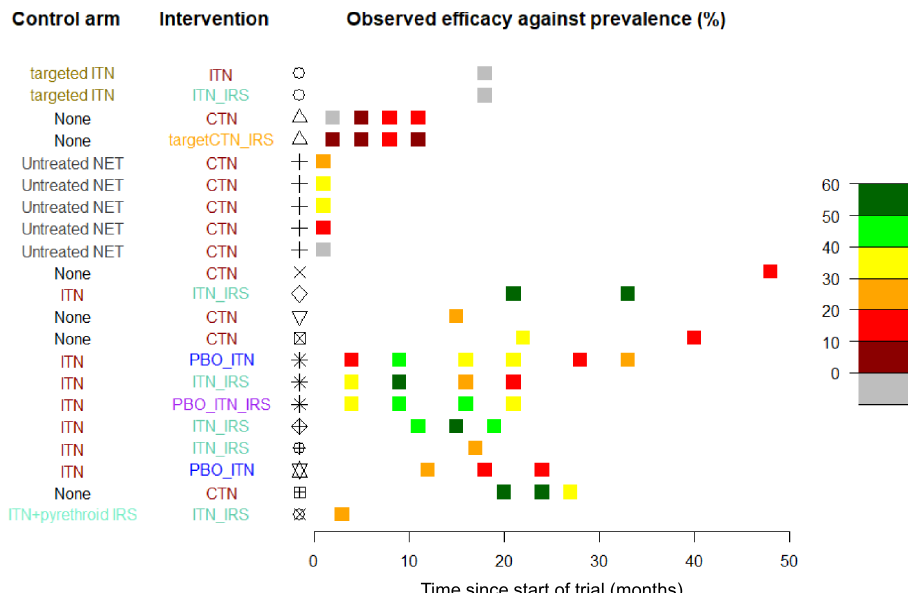
Fig. 1 Summary of the randomised control trials completed on ITNs, indoor residual spraying (IRS) or a combination of these intervention tools. The fi rst column indicates the control arm interventions to which the tested intervention (2nd column) are compared. Intervention types represented include no-intervention (black), untreated mosquito nets (grey), conventional nets dipped in pyrethroid insecticide every 6 – 8 months (CTNs, red), pyrethroid-only insecticide-treated nets, which incorporate insecticide (ITNs, red), pyrethroid-PBO ITNs (blue), or ITNs together with IRS (pyrethroid-only ITN + IRS, pale green, pyrethroid-PBO ITN + IRS, purple) or IRS only (orange). The country and study represented are shown in columns 3 and 4; symbols correspond to the studies shown in Fig. 2 and references in the supporting information Supplementary Table 1. The ef fi cacy estimate reported in each of the trials is shown by the coloured square box at the appropriate timepoint the survey was conducted following start of the trial. It is calculated as the mean difference between reported malaria prevalence in the intervention arm relative to the control arm, with greener colours indicating higher observed differences. Trials vary substantially in the number and timing of the cross-sectional Table 1) were identi fi ed by the systematic review that ful fi l the